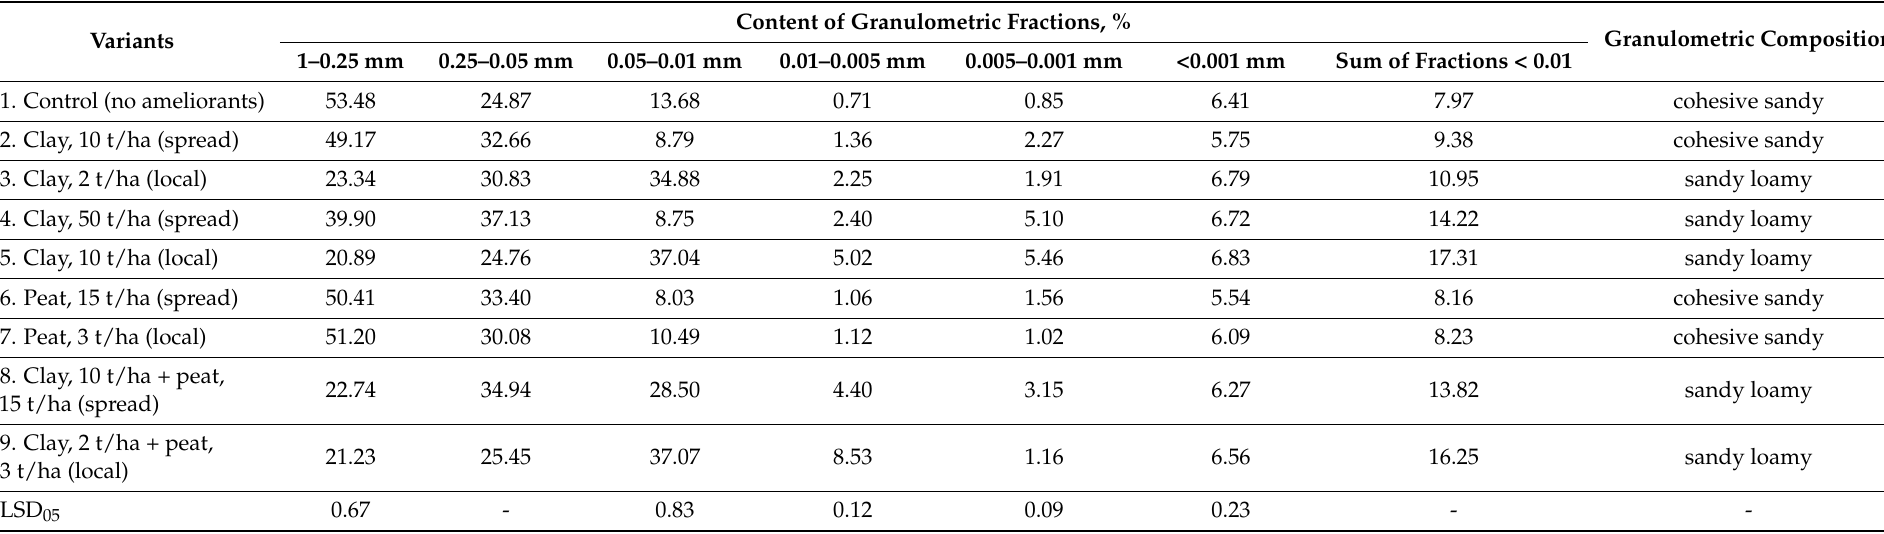
Table 3. Changes in the granulometric composition of sod-podzolic cohesive sandy soil under the influence of claying (field experiment).